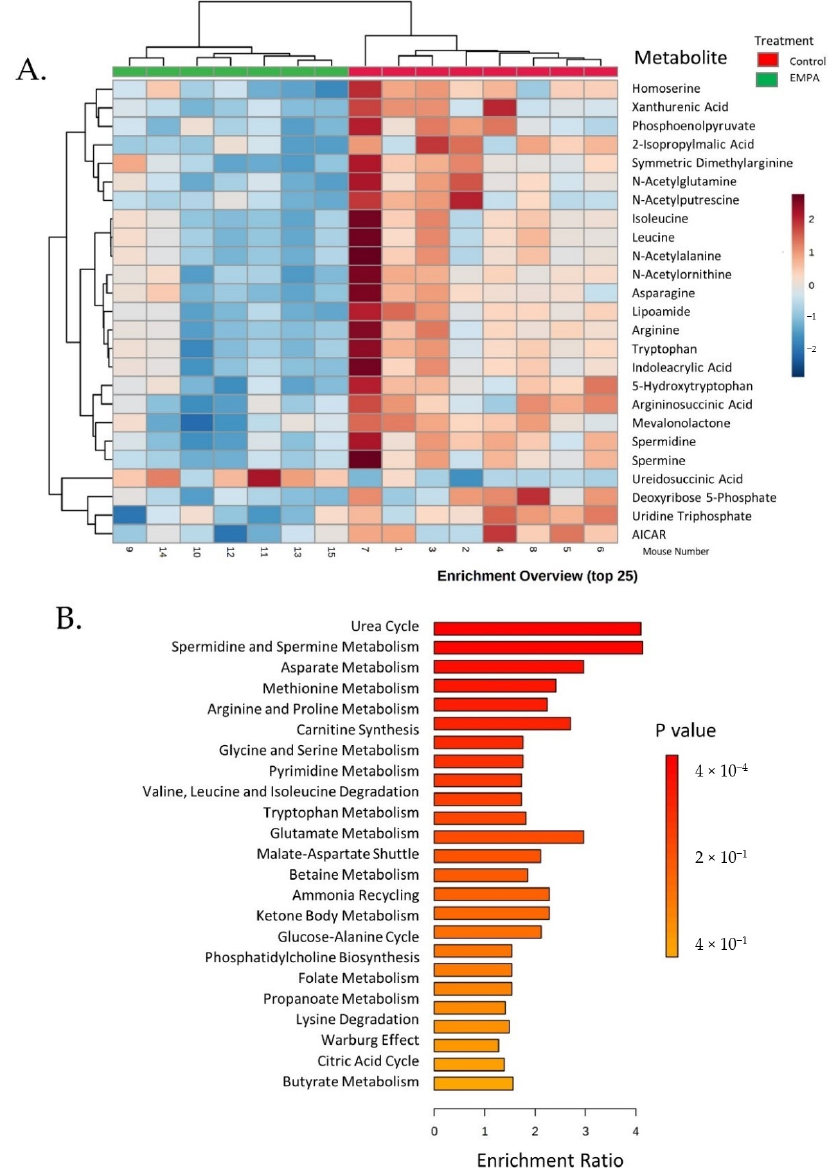
Figure 4. Clustering and enrichment of targeted metabolites. ( A ) Hierarchical clustering (top 25) of metabolite levels in EMPA (green, left) and control (red, right)-treated mice kidney cortex. Key shows relative levels of metabolites (log base 2) with color intensity scale red indicating high levels and blue low; ( B ) enrichment overview of main pathways down-regulated by